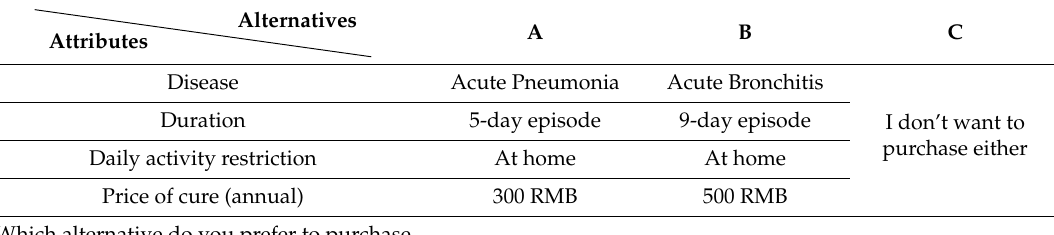
Table 2. A typical choice